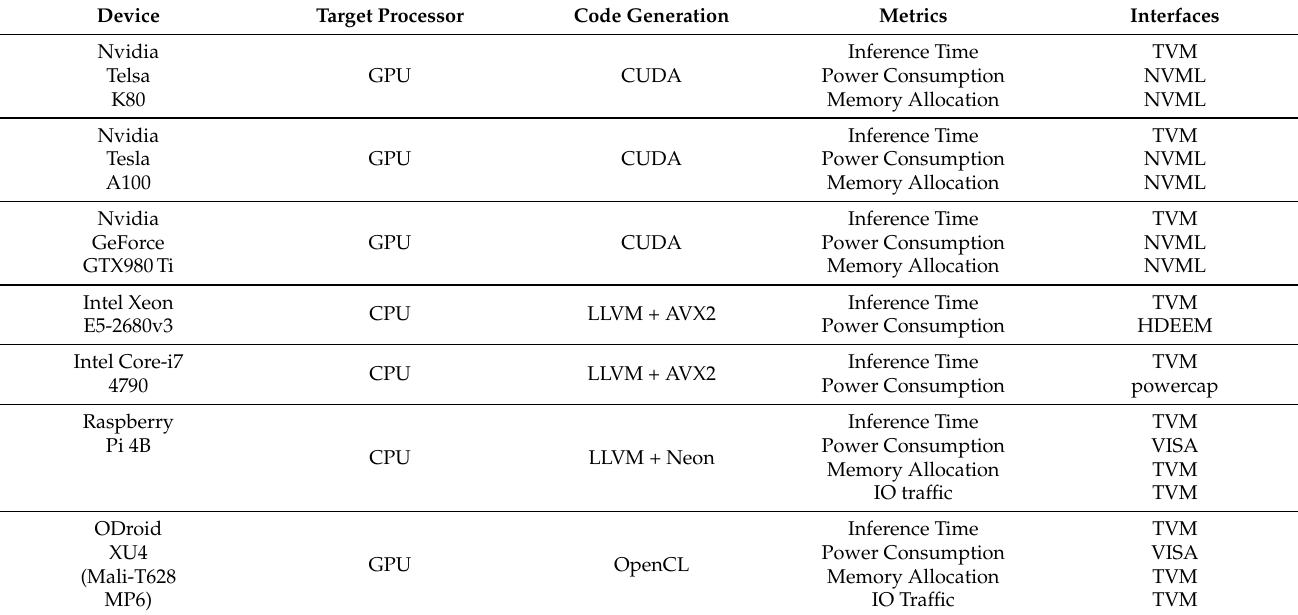
Table 2. Overview of profiled targets and measured